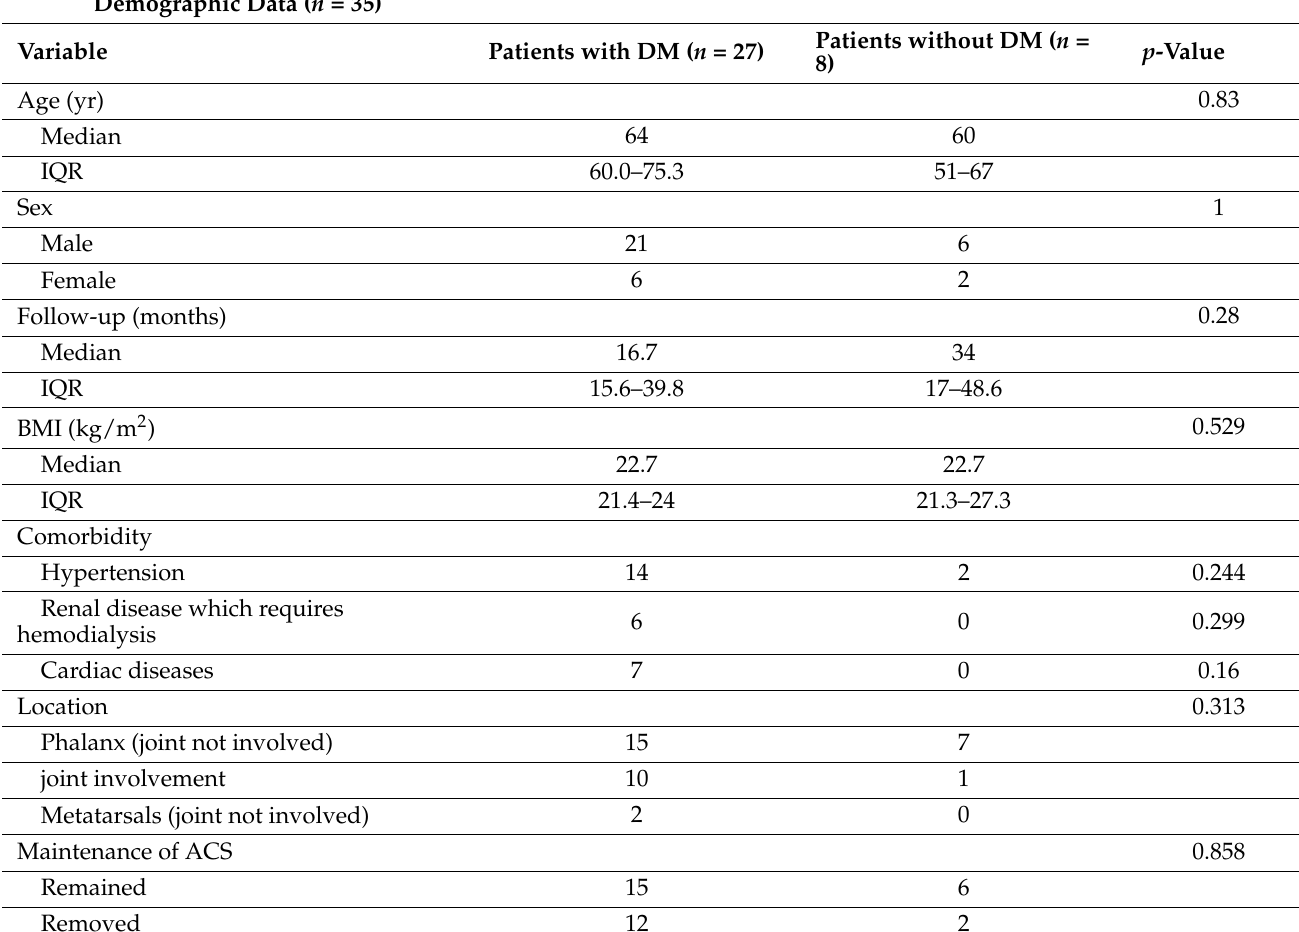
Table 1. Demographic features and final status of ACS between diabetic and non-diabetic group of the patients.